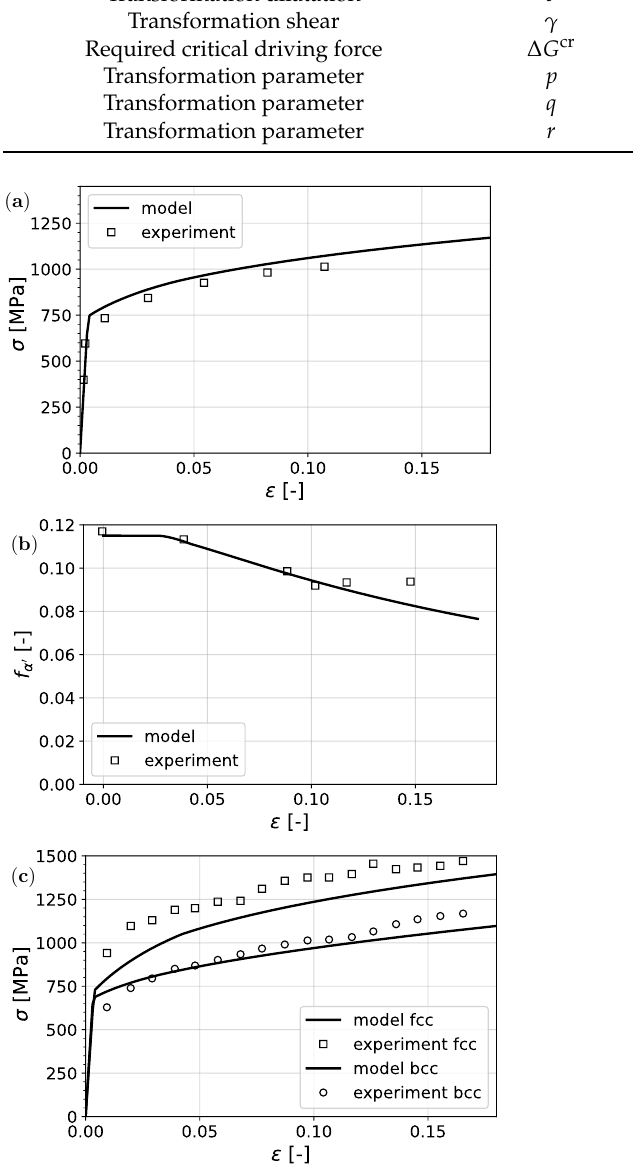
Figure 5. Prediction of the model compared to experimental results by Lani et al. [28]: ( a ) stress vs. strain, ( b ) retained austenite vs. strain and ( c ) stress resolved in bcc and fcc phases vs. overall